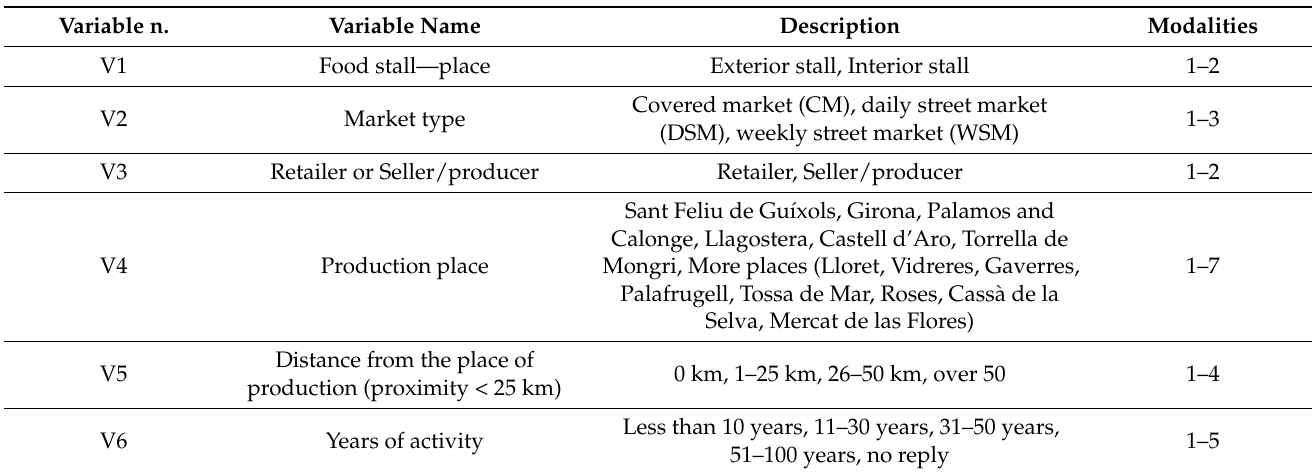
Table 1. Main variables chosen for processing, coding of the name, and methods of recording the interviews with Sant Feliu de Gu í xols market